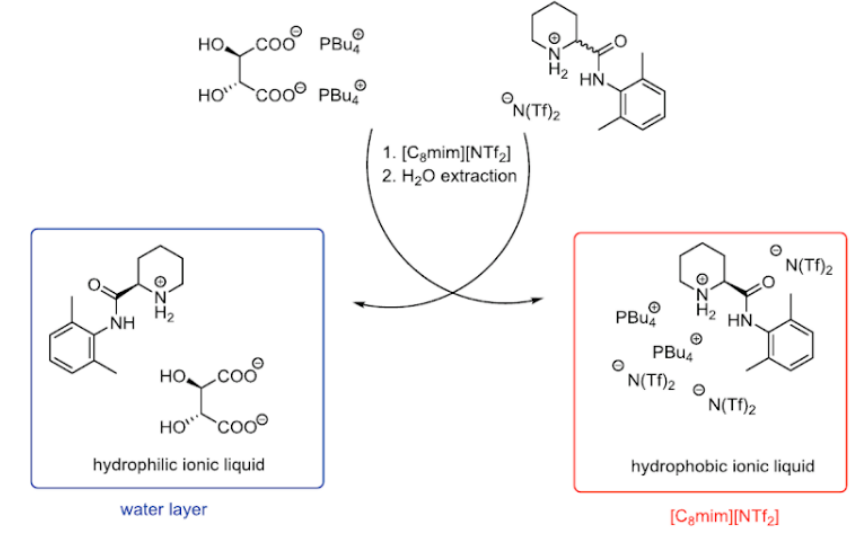
Figure 9. Enantioselective liquid–liquid extraction with the chiral ionic liquid [PBu 4 ] 2 [ R , R -tartrate] (adapted from Zgonnik, 2012) [171].